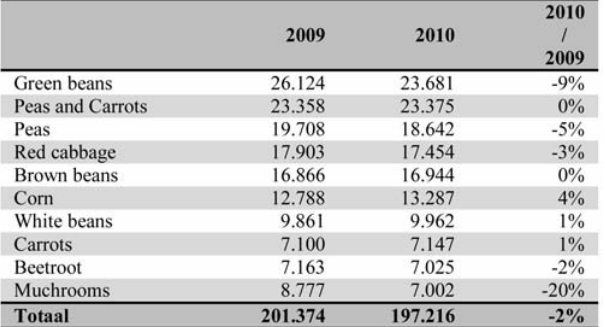
Table 8. Supermarket sales canned vegetables ( € ×